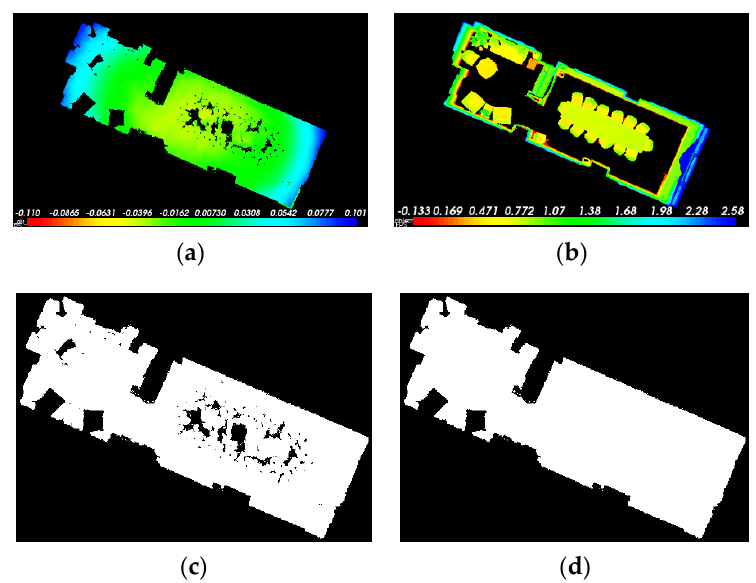
Figure 15. Initial passable area map (PAM) and space obstacles: ( a ) direction-corrected ground, ( b ) space obstacles, ( c ) binary image ( I grd ), and ( d ) initial PAM in image format.